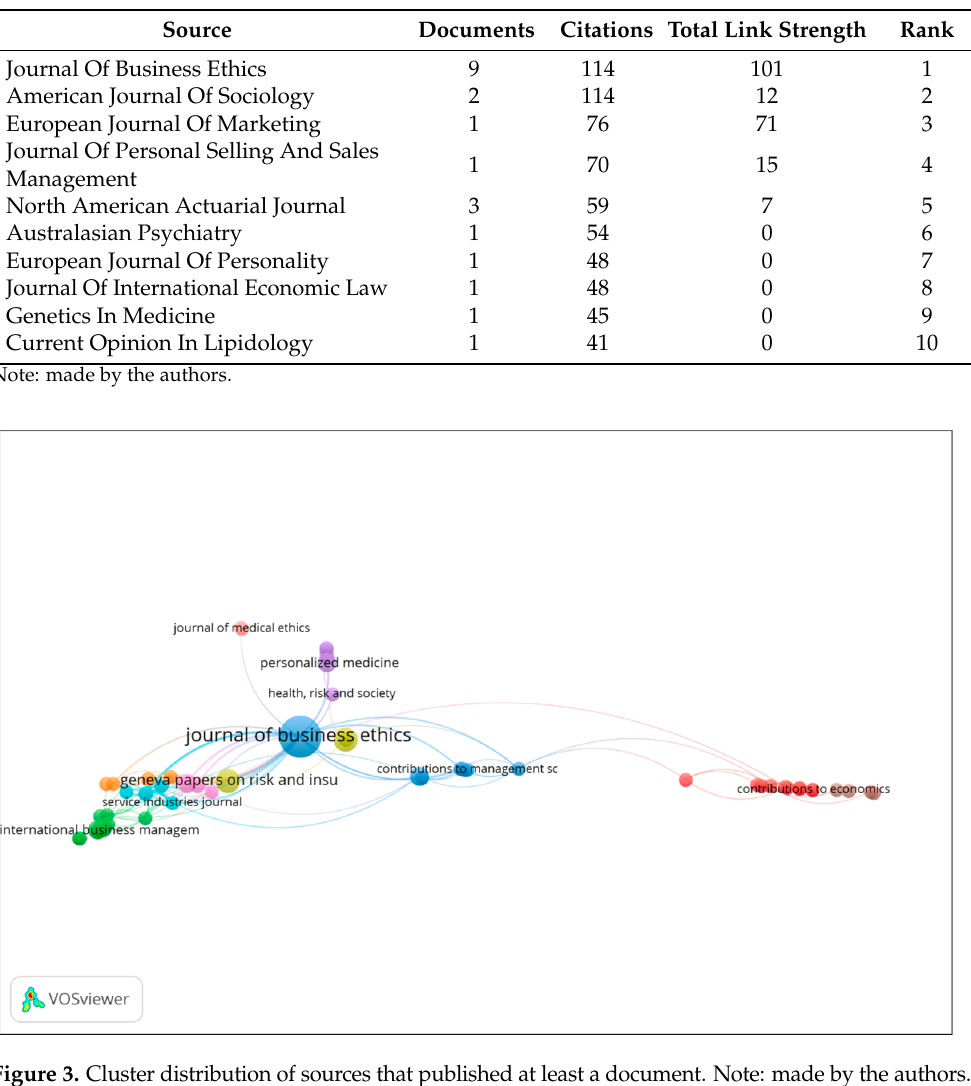
Table 2. Top 10 journals in the dataset by the number of citations received per publication.